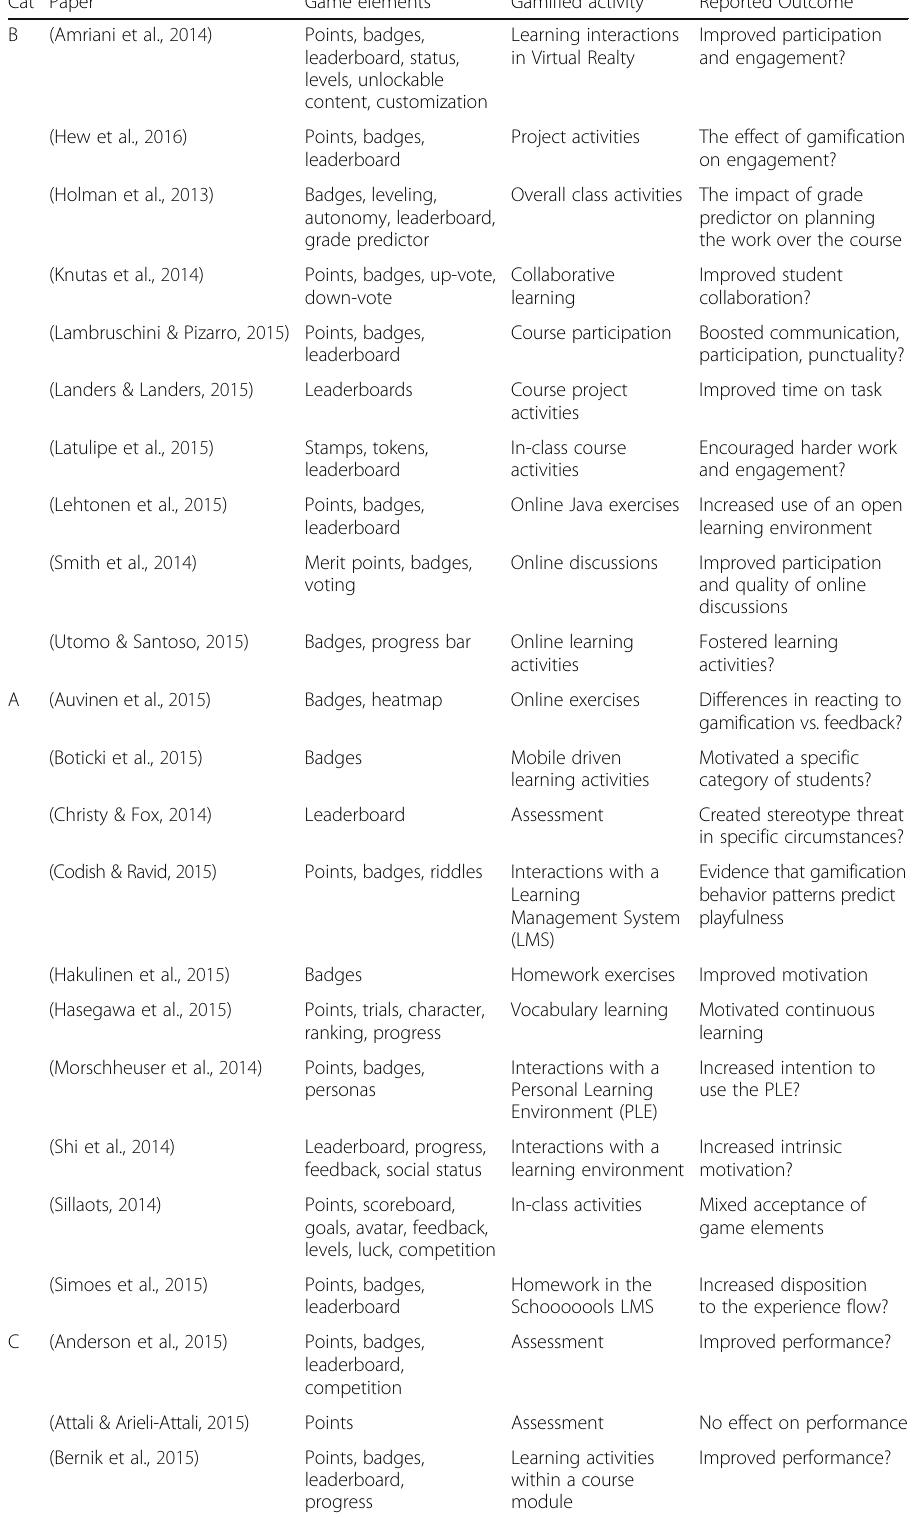
Table 6 Categorization of the studies falling into a single category (Behavioral (B), Affective (A) or Cognitive